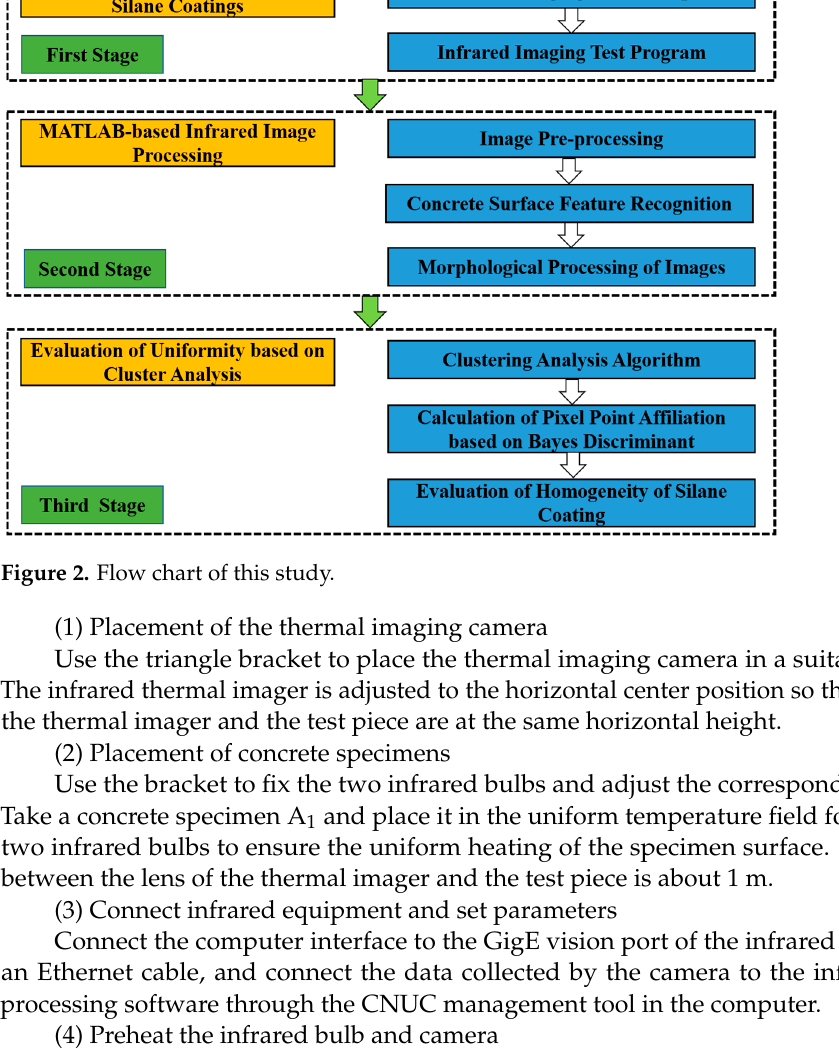
Figure 1. Infrared imaging detection system.